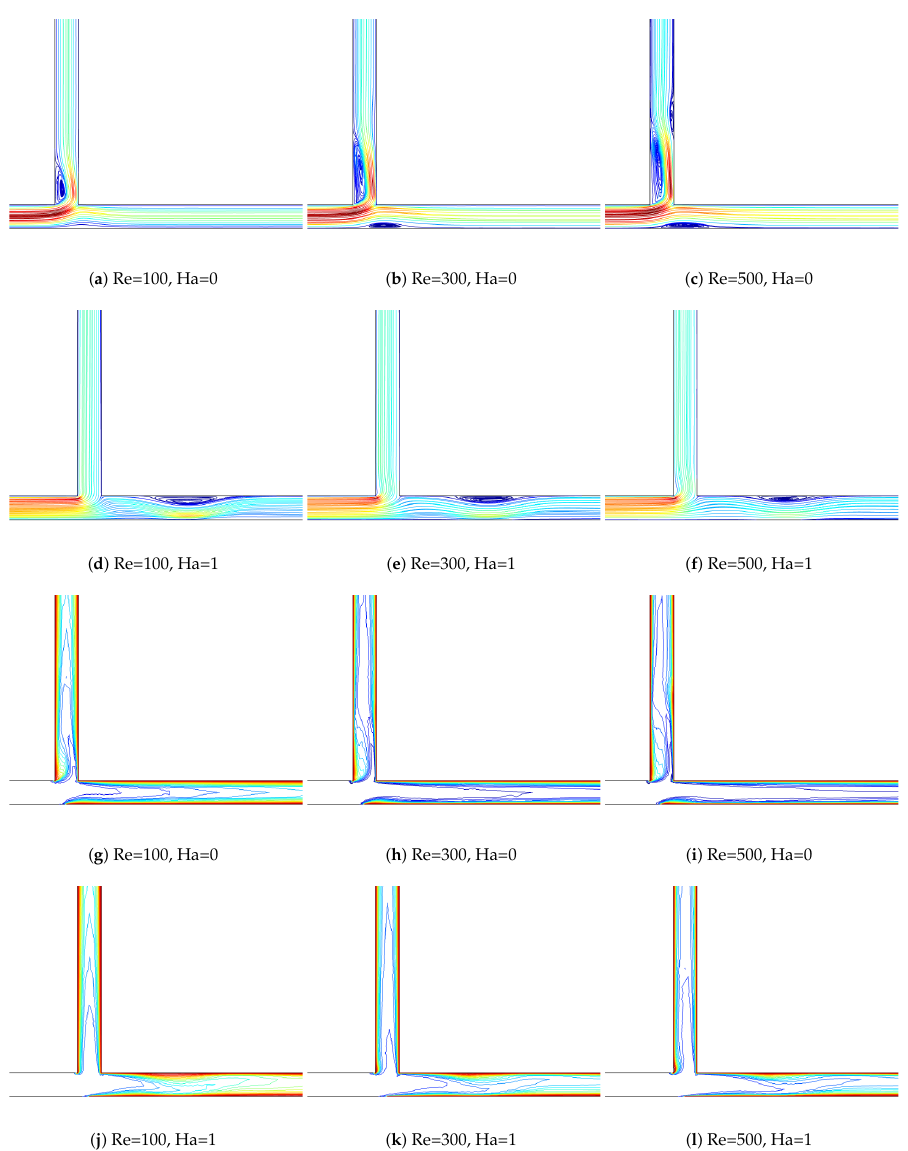
Figure2. EffectsofReynoldsnumberonthestreamline(a-f)andisotherm(g-l)variationsintheabsence Figure 2. Effects of Reynolds number on the streamline ( a – f ) and isotherm ( g – l ) variations in the and presence of magnetic field ( φ = 0.02). absence and presence of magnetic field ( φ =